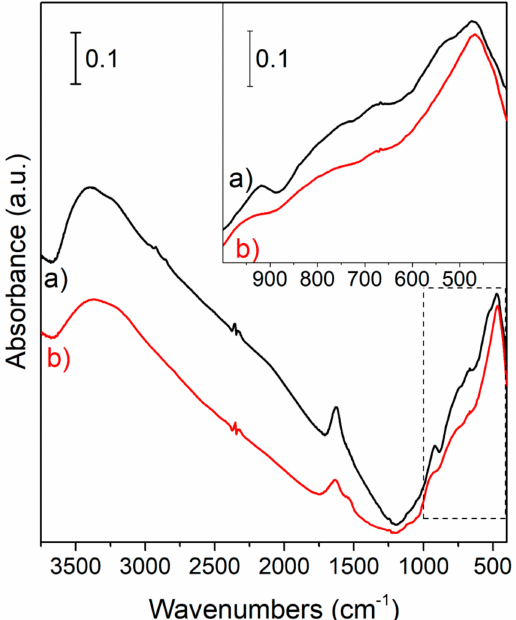
Figure 2. FTIR spectra of hydrogen titanate nanotubes (a) before and (b) after ion-exchange with Fe(NO 3 ) 3 0.01M solution (Fe-TIT#01). In the inset, the two spectra are shown and compared in the 1000–400 cm − 1